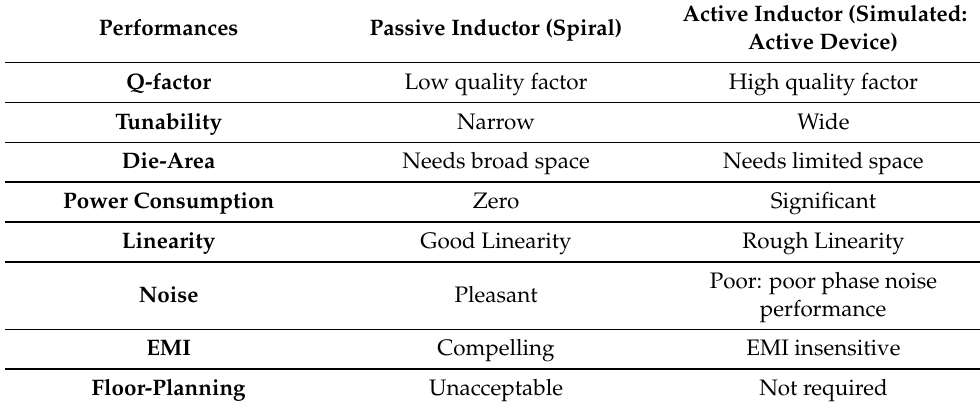
Active Inductor